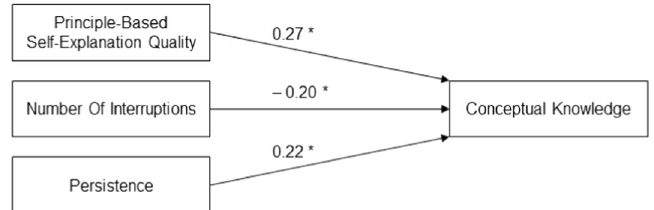
Fig. 4 Regression on conceptual knowledge. Standardized beta coefficients, * p <